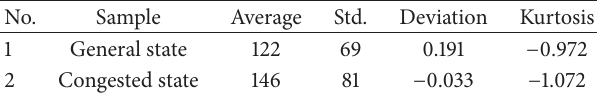
Table 3: Results of statistical analysis on the average saccade speed.